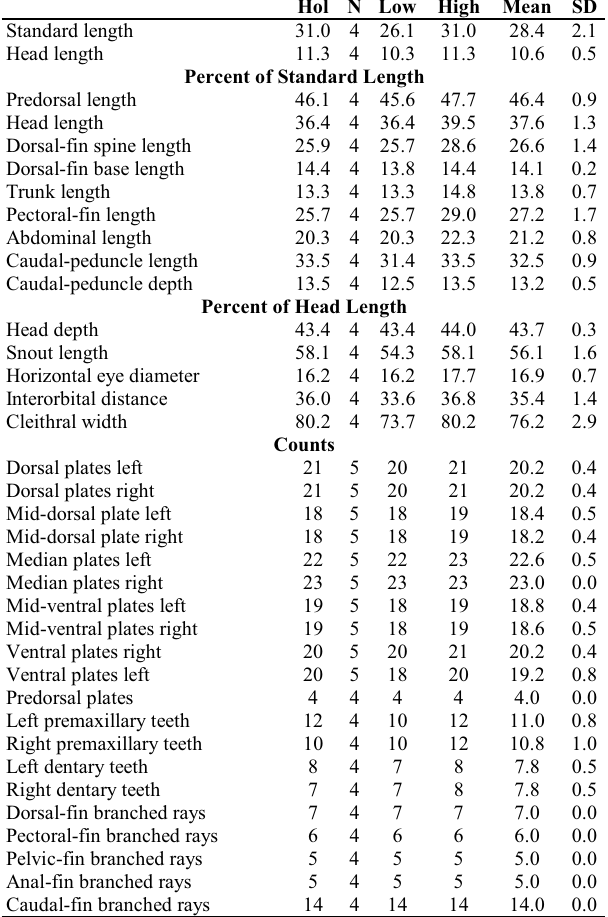
Table 2. Morphometric and meristic data for Parotocinclus muriaensis . Hol =